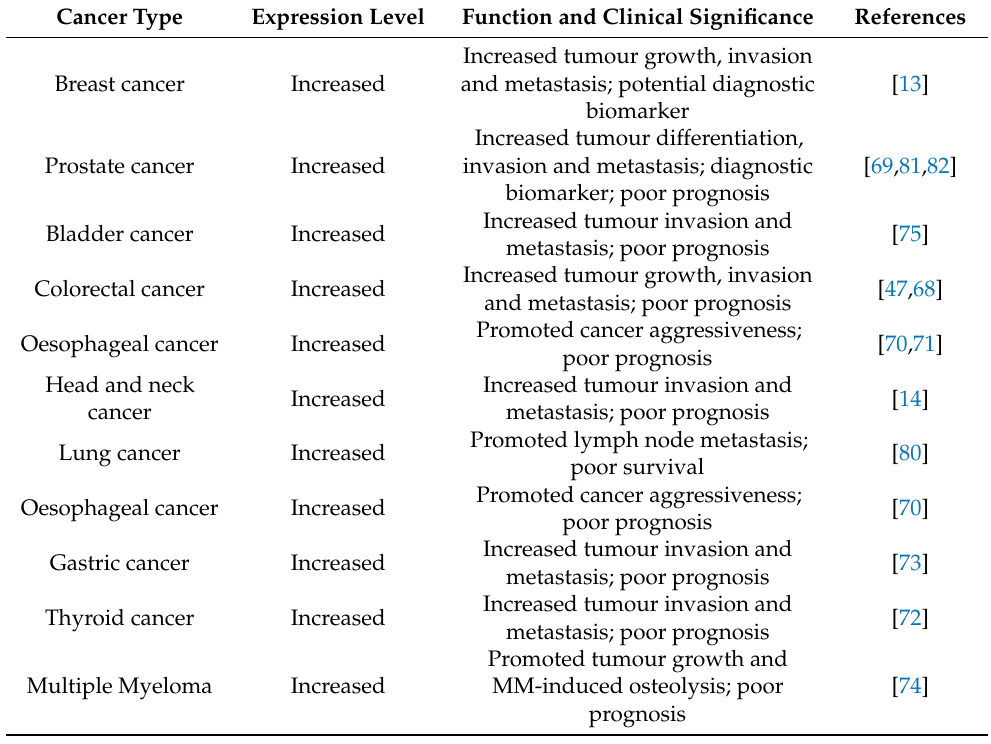
Table 1. MMP-13 expression in common cancer and its function and clinical